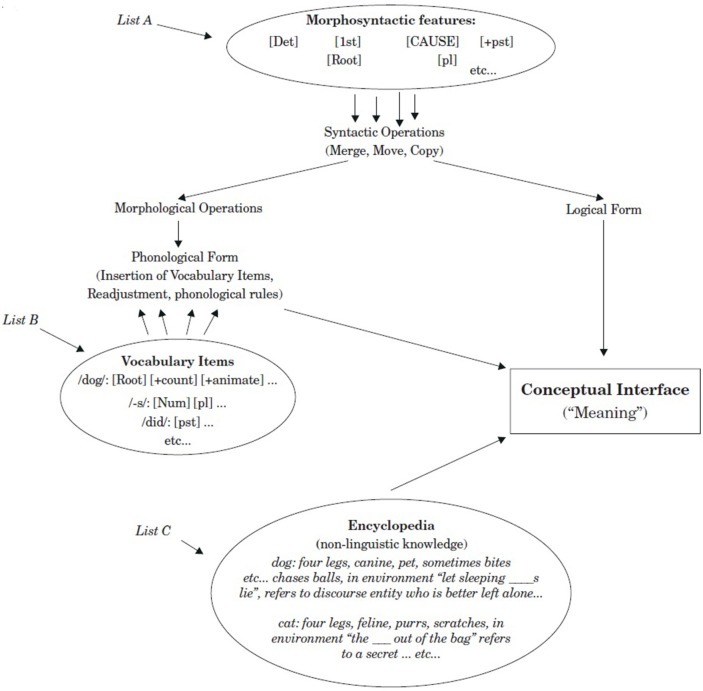
Distribution of labor in distributed morphology (Harley and Noyer, 1999, p. 3).